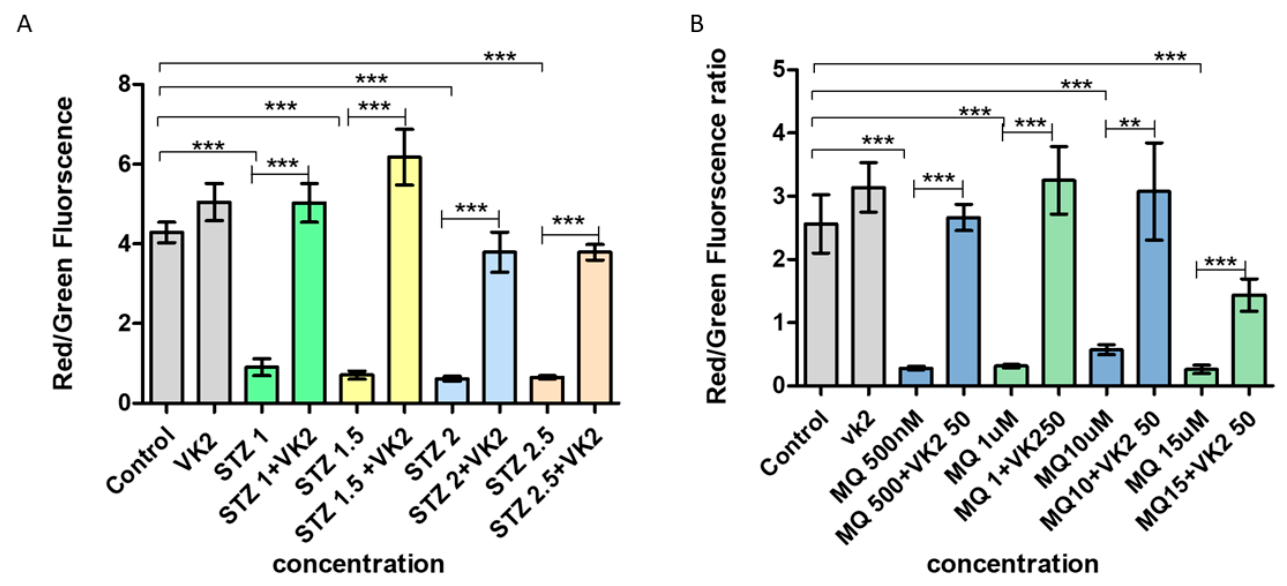
Figure 4. Measurement of mitochondrial membrane depolarization state using the JC1 assay in human SH-SY5Y neuroblastoma cells after ( A ) streptozotocin treatment and post-treatment with vitamin K2 (50 µ M) and ( B ) menadione treatment (MQ) and post-treatment with vitamin K2. The Y -axis represents the red/green fluorescence ratio and the X -axis represents the concentrations of streptozotocin and menadione. The data are presented as mean ± SEM. Statistical analysis was performed using Student’s t -test and differences with p -values ≤ 0.05 were designated as significant. * p < 0.05, ** p < 0.01, and *** p < 0.001 denote significant differences compared to the control and between the treatment groups. [STZ—streptozotocin; VK2—vitamin K2; SV—post-treatment of streptozotocin (1–2.5 mM)-treated cells with vitamin K2 (50 µM); MQ—menadione; MQ + VK2—post-treatment of menadione (500 mM–15 µM)-treated cells with vitamin K2 (50 µM)].